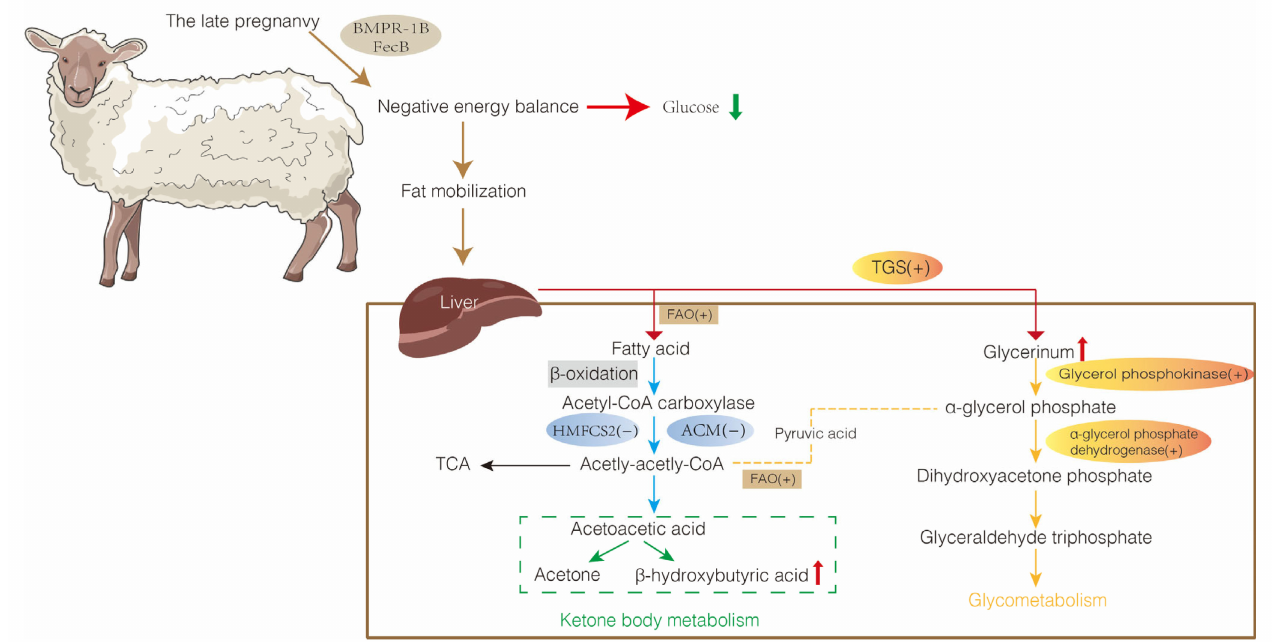
Figure 3. Metabolic mechanisms of pregnancy toxemia in the liver of sheep. TCA, tricarboxylic acid; FAO, fatty acid oxidation; ACM, acetyl coenzyme metabolism; TGS, triglyceride synthesis; HMGCS2, hydroxy methylglutaryl-CoA synthase